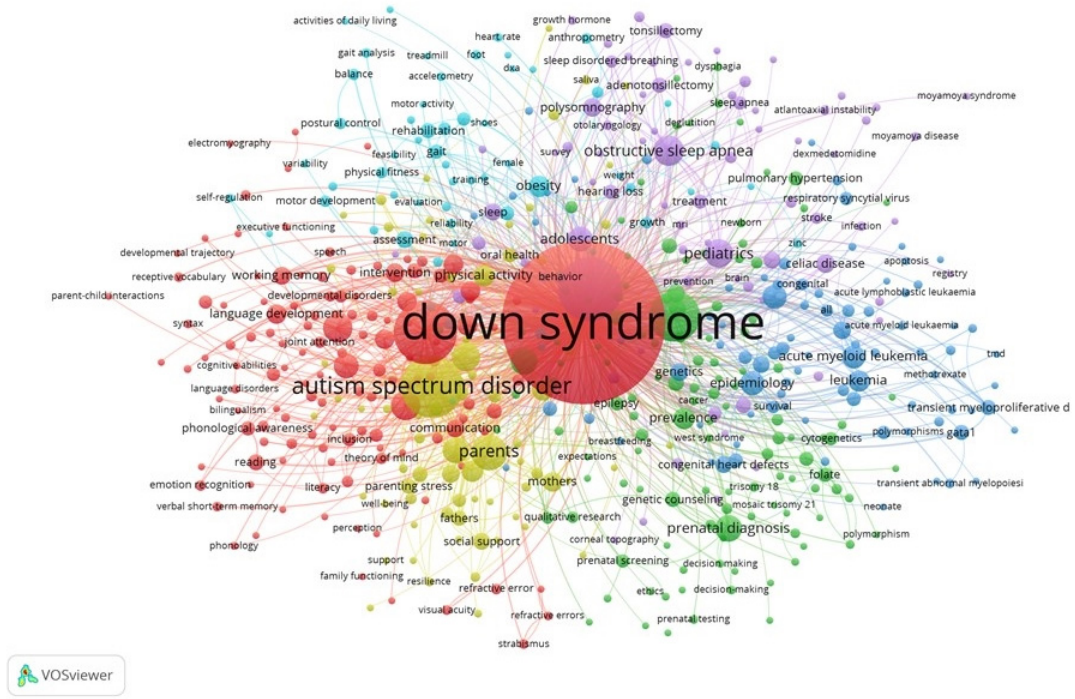
Figure 1. Co-occurrence network of keywords by the